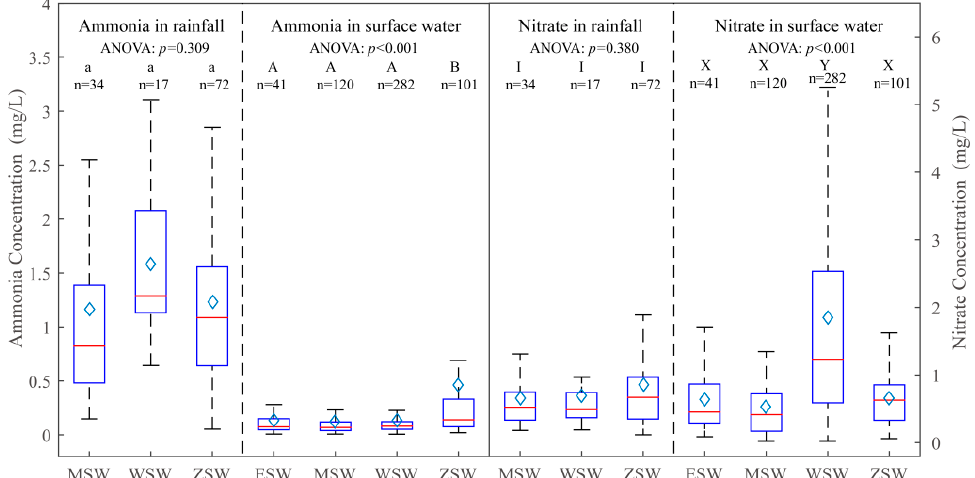
Figure 2. NH 4+ -N and NO 3 − -N concentrations in precipitation and surface water in different sub-watersheds and the results of one way ANOVA. Boxplots illustrate the 25th, 50th, and 75th percentiles; the whiskers indicate the 5th and 95th percentile; diamonds in boxplots denote mean values. Letters above the upper whiskers are ANOVA results, and n is sample size.